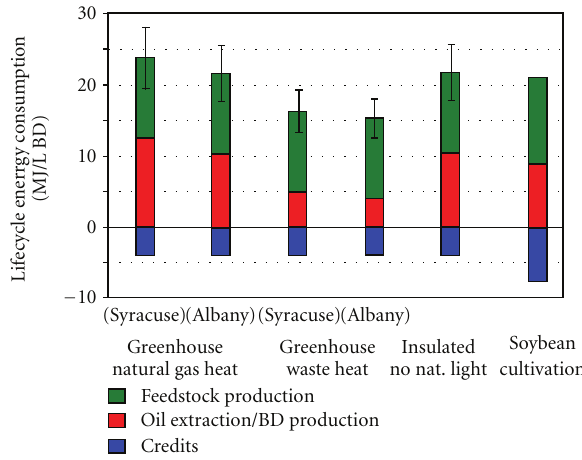
Figure 7: Total life cycle energy consumption by life cycle stage. The error bars represent 95% confidence intervals on the total lifecycle energy consumed.